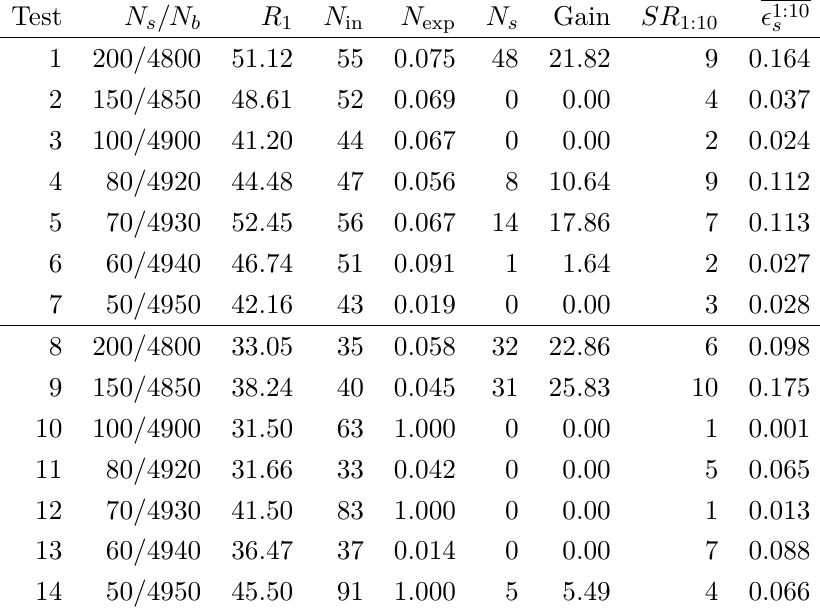
Table 5 . Results of a few additional RanBoxIter test runs on 5000 events from the HEPMASS dataset, using Algorithm 2 (tests 1–7) and Algorithm 1 (tests 8–14) for the initialization of the search boxes, and scans of subspaces with dimension up to D 0 = 12 . The last two columns report max the number of signal-rich boxes and the average signal efficiency of the ten most significant boxes. See the text for more